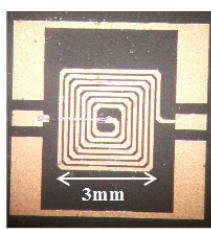
Figure 8: Photo of the manufactured spiral micro-inductor with thick YIG layer